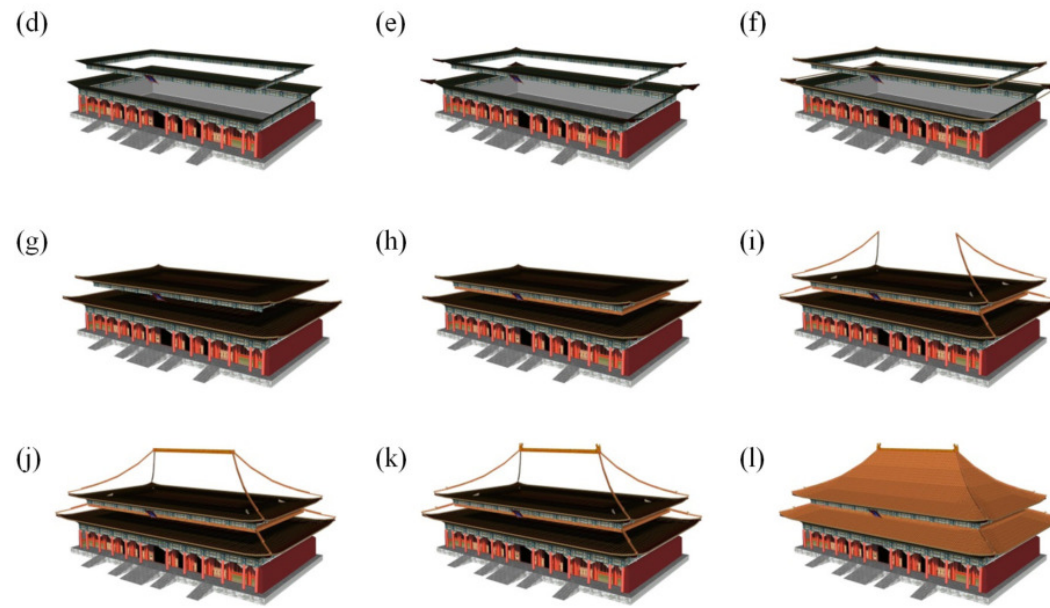
Figure 10. The bottom-up model process of Tai-he Palace. ( a ) Bottom ground; ( b ) add walls; ( c ) add doors, windows and pillars; ( d ) add dou-gongs (brackets); ( e ) add wing corners; ( f ) add main eaves; ( g ) add ceilings; ( h ) add horizontal ridges; ( i ) add vertical ridges; ( j ) add main ridge; ( k ) add chi’h-weis and tsun-shous; ( l ) last slope surfaces. Certain components, such as doors, windows and dou-gongs, are replaced by texture pictures for simplification.